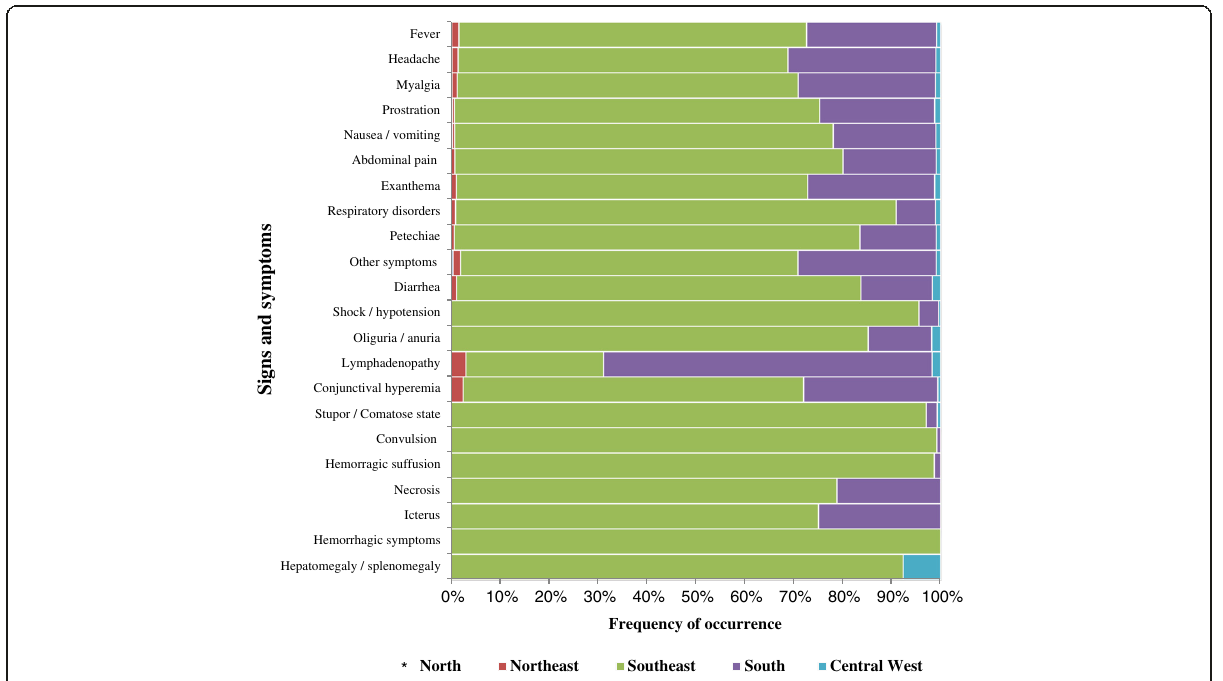
Fig. 3 Main spotted fever signs and symptoms reported to the Notifiable Diseases Information System, by Brazilian region, between 2007 and 2015. *In the North region only one case was reported that presented the following symptoms: nausea/vomiting, prostration, myalgia, fever and headache